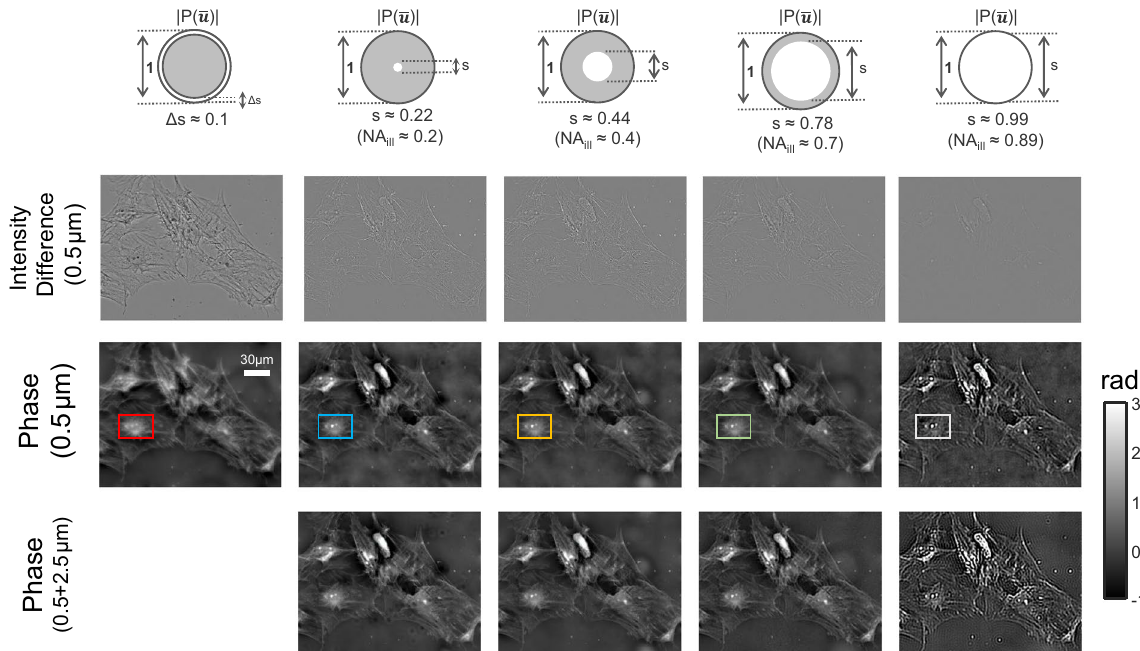
Figure 10. Comparison of annular illumination TIE with circular illumination TIE for imaging of fixed human BMSC cells. First row: intensity difference from two defocused images with Δ z = ± 0.5 μ m. Second row: phase reconstruction with of different illumination settings with single defocus distance ( Δ z = 0.5 μ m). Second row: phase reconstruction with different illumination settings and single defocus distance. Third row: phase reconstruction with different illumination settings and two defocus distances ( Δ z = 0.5, 2.5 μ